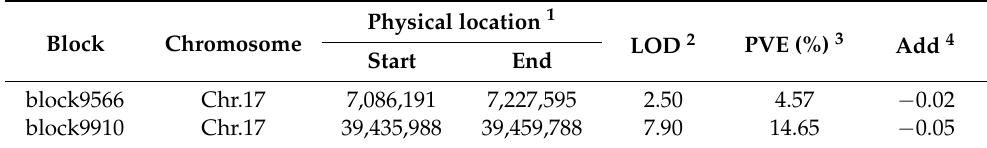
Figure 2. Physical map of the genomic regions associated with resistance to seed coat mottling determined by QTL. The predicted genes in the two blocks are based on the reference genome GlymaWm82.a2.v1 (https://jgi.doe.gov/, accessed on 3 May 2022). Table 1. The substituted regions associated with resistance to seed coat mottling identified by QTL analysis.